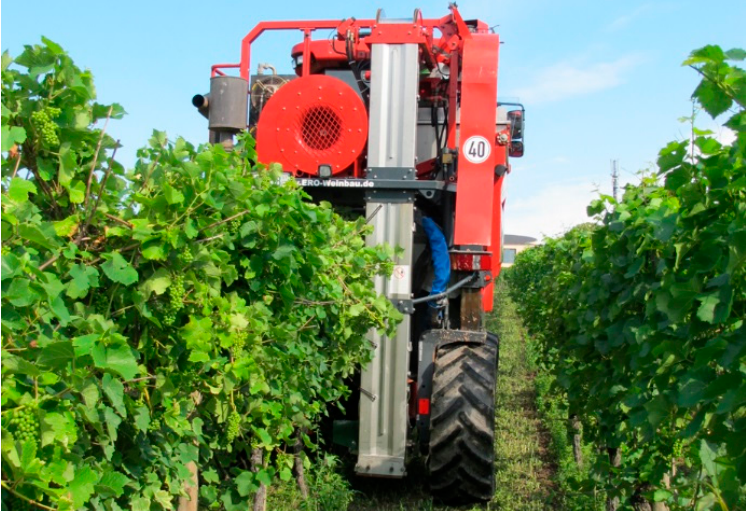
Figure 1. Mechanical thinning in the SMPH MT 1 and SMPH MT 2 treatments on 30 July 2015. SMPH, semi-minimal pruned hedge; MT, mechanical thinning.